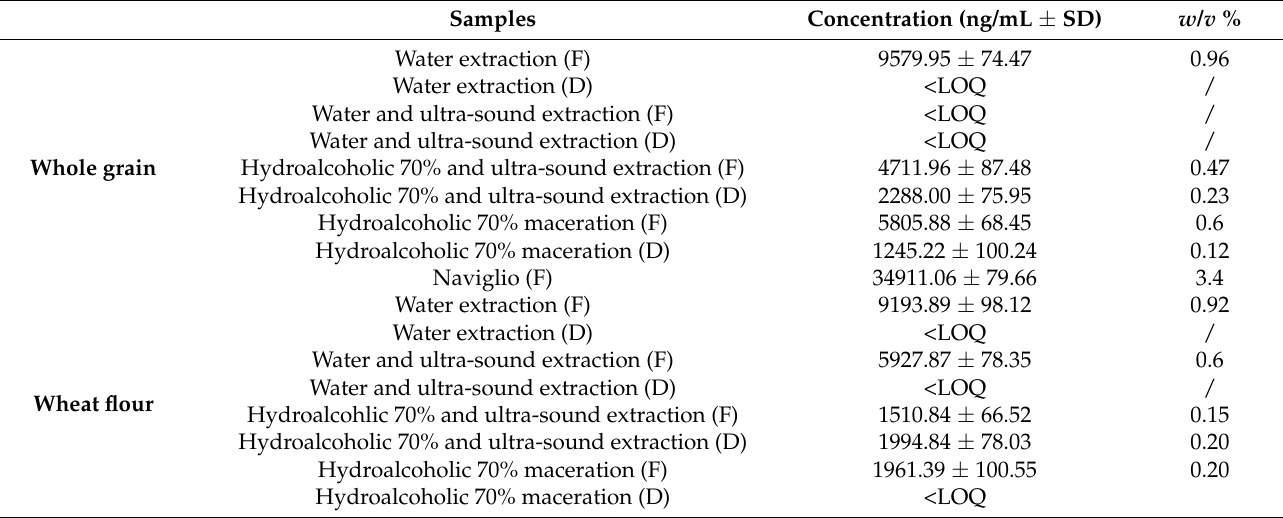
Table 3. Results of Quantification of AzA in different wheat